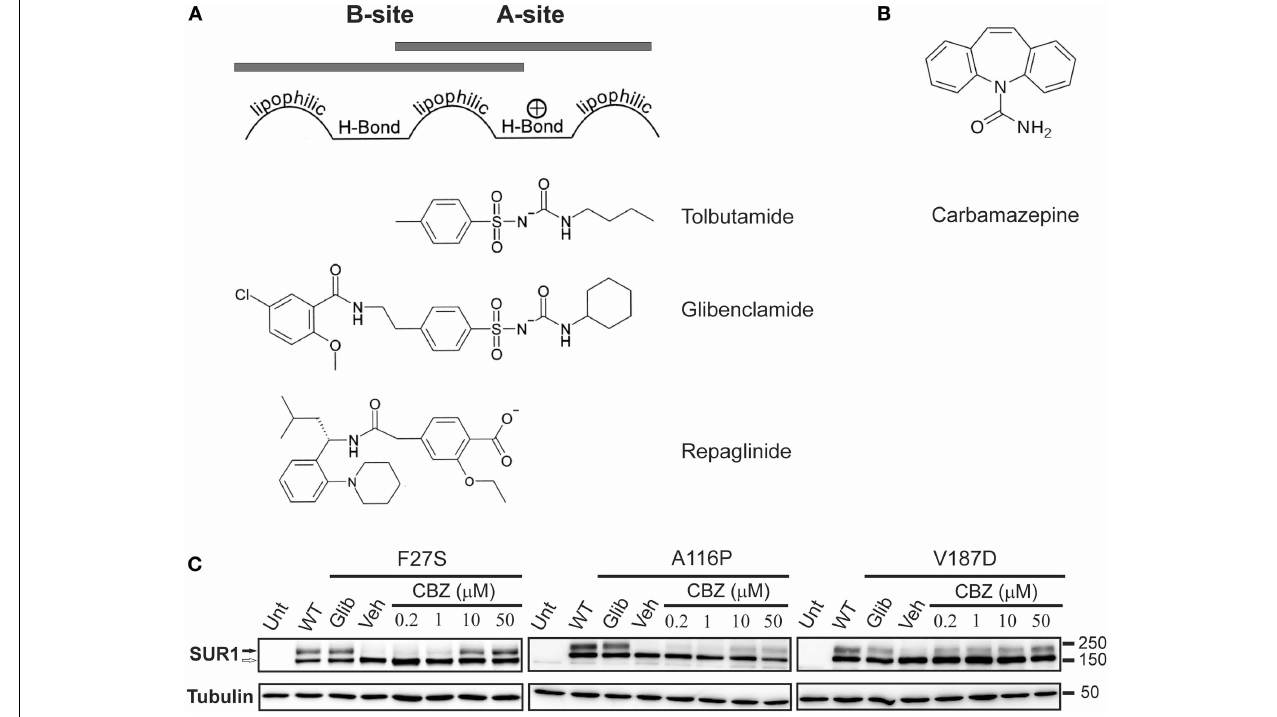
immunoblots: a lower core glycosylated (immature; open arrow) form that has not exited the ER and an upper complex-glycosylated (mature; solid arrow) band that has trafficked through the Golgi. Incubation of cells with glibenclamide (5 μ M; Glib) or carbamazepine (CBZ) for 16h increased levels of the mature band of TMD0 trafficking mutants compared to those treated with DMSO (veh). The effect of carbamazepine was dose-dependent, with an effect detectable at a concentration as low as 0.2 μ M. Untransfected control is shown for comparison. Adapted from Figure 1 in Chen et al.